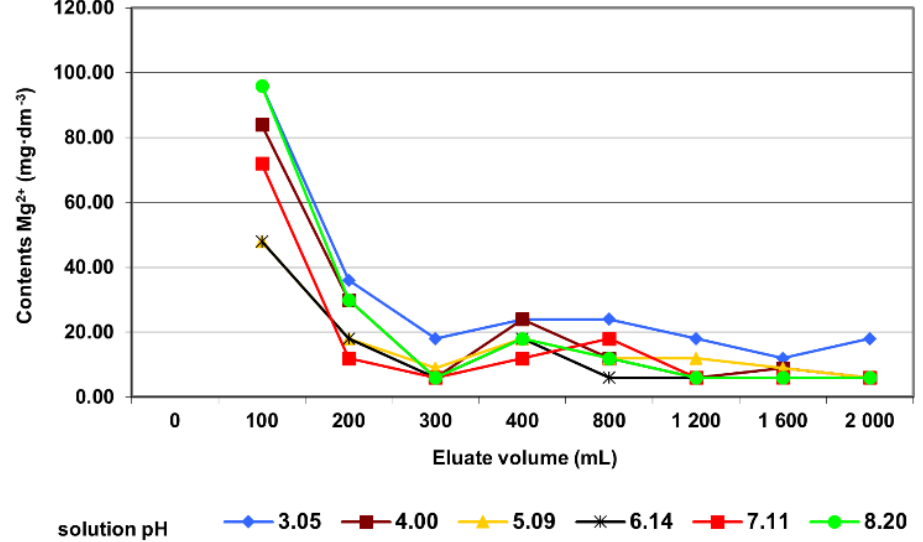
Figure 6. Contents of Ca 2+ ions in successive portions of the collected eluate depending on the pH of the initial leaching solution.